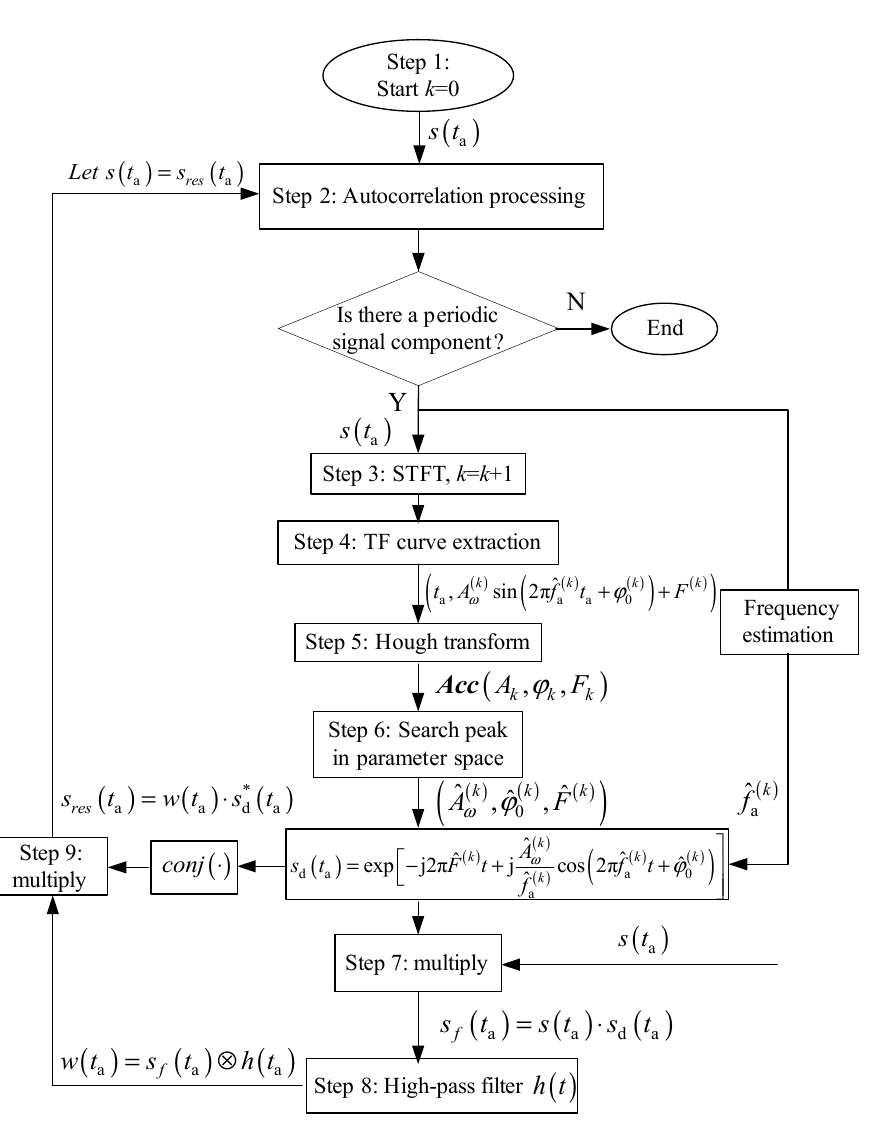
Figure 4. The algorithm flow chart.